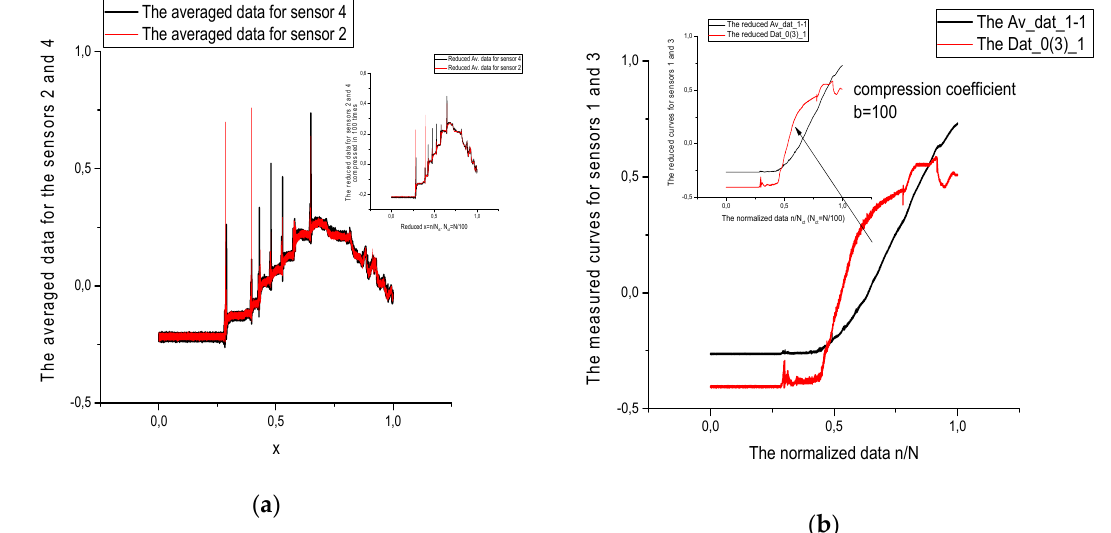
Figure 2. ( a ) On the left. Here, we plot the initial data containing 263,600 data points for the averaged data associated with reference sensor (bolded line). Red line corresponds to the averaged data for sensor − 2. In the right corner above we place the reduced data for the same data compressed in b = 100. The correlation coefficient equals 0.987. They exhibit the scaling/fractal properties, from one side, and accelerate the calculations, from another side. Vertical axis gives the value of response in Volts. Horizontal axis is dimensionless and the measured data points are normalized to the unit value. ( b ) Data for the reference function (bolded black line) are shown on the right. The red line depicts the data for sensor 0 (3). In the left corner of this figure we depict the same data compressed in b = 100 times. As it was marked in Figure 2a, vertical axis gives the value of response in Volts and horizontal axis is dimensionless and the measured data points are normalized to the unit value.